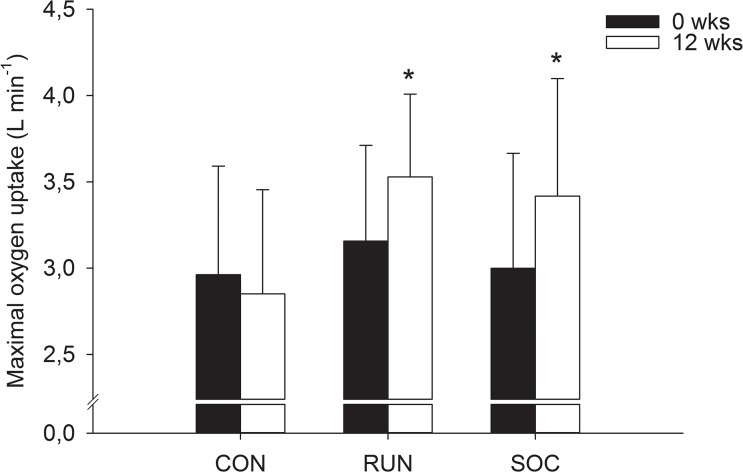
Differences among soccer (SOC), running (RUN) and control (CON) group in VO2max absolute values (L·min-1); *—denotes significant difference compared to baseline (p<0.05).